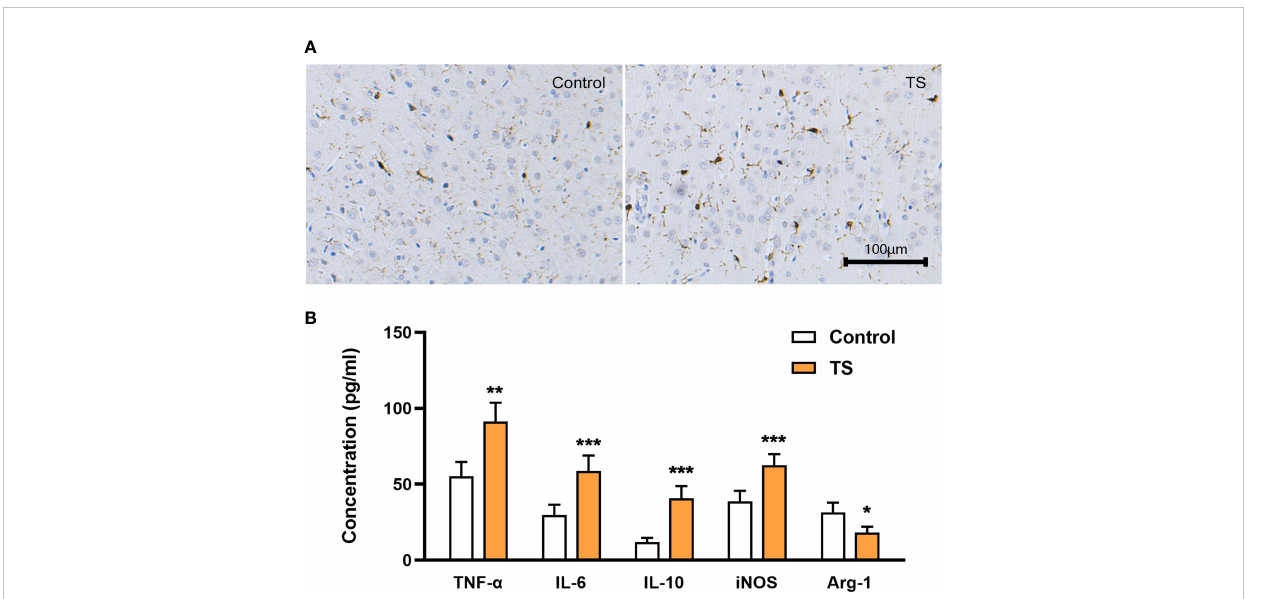
FIGURE 2 Activation of striatal microglia is involved in TS. (A) The TS group has a trend toward increased Iba-1 positive cells, with asymmetrical branches and an amoeba-like appearance. (B) The levels of in fl ammatory factors TNF- a , IL-6, IL-10, and iNOS are signi fi cantly increased in the striatum of TS